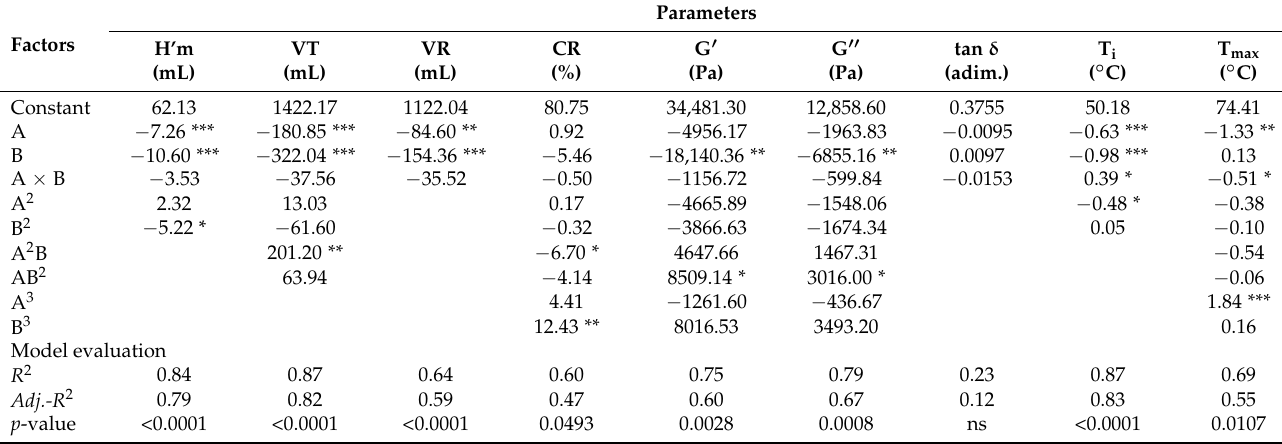
Table 3. ANOVA results of the mathematic models fitted for dough fermentation and fundamental rheological proper-